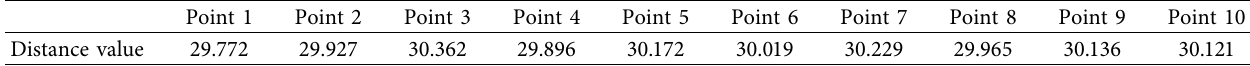
Table 1: Part of the distance data between surfaces